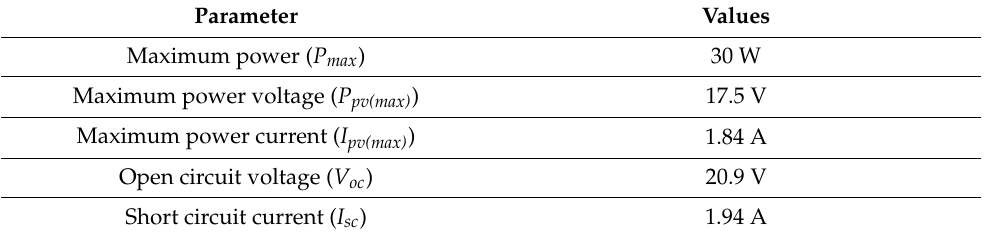
Table 3. Specification of the solar power supplied by solar power